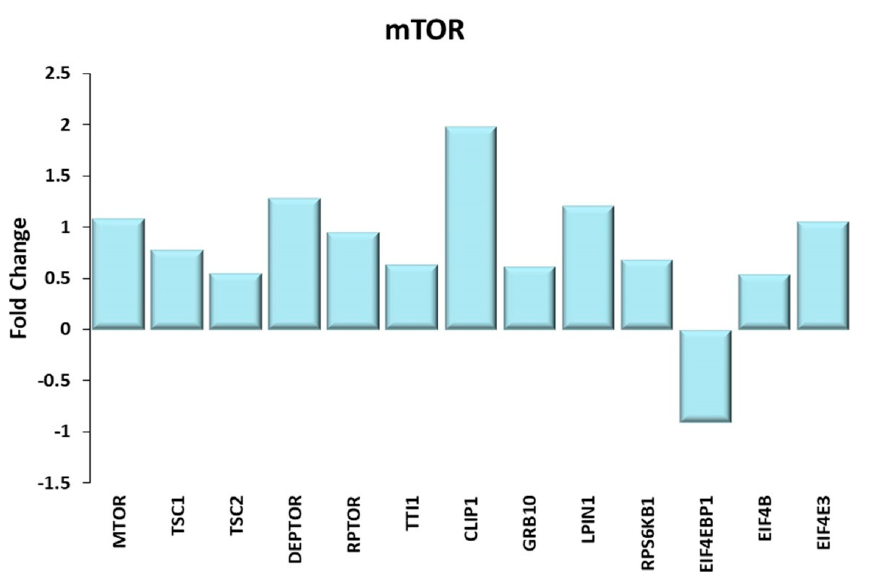
of TRA and SED subjects. MTOR: mechanistic target of rapamycin kinase; TSC1 and TSC2: TSC complex subunit 1, 2; DEPTOR: DEP domain containing MTOR interacting protein; RPTOR: regulatory associated protein of MTOR complex 1; TTI1: TELO2 interacting protein 1; CLIP-1: CAP-Gly domain containing linker protein 1; GRB10: growth factor receptor bound protein 10; LPIN1: lipin 1; RPS6KB1: ribosomal protein S6 kinase B1; EIF4EBP1: eukaryotic translation initiation factor 4E binding protein